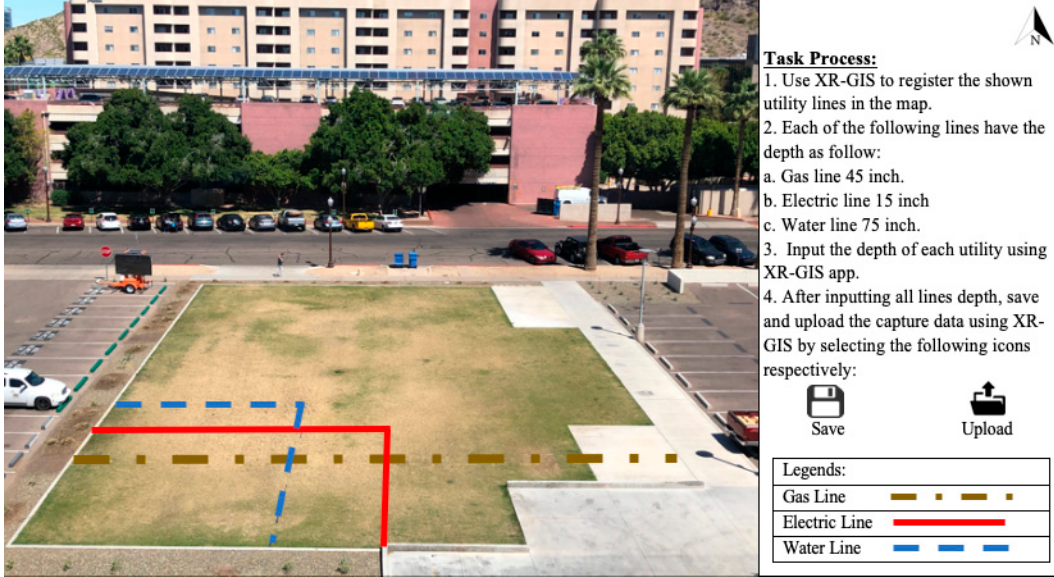
Figure 6. Map and task process for testing XR-GIS.